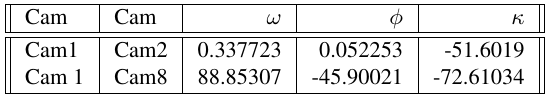
Table 7: Results of the relative orientation with simultaneous es- timation of the image corrections (see sec. 3.4)